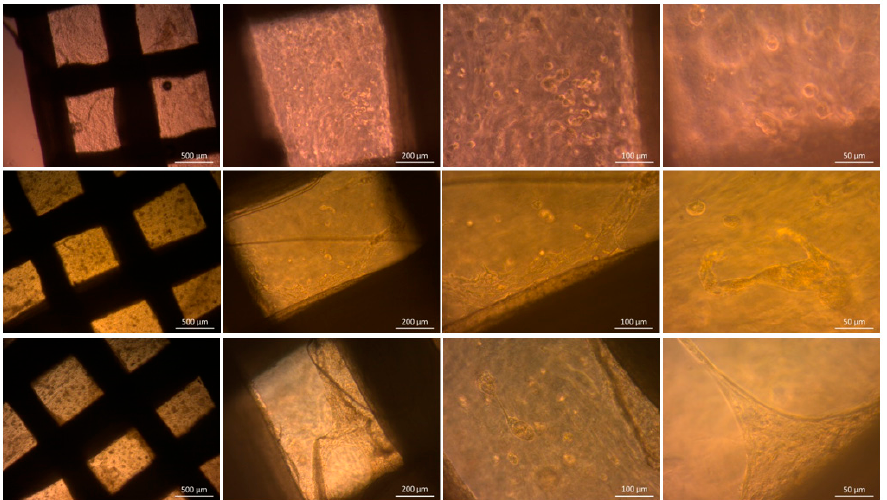
Figure 12. Optical microscope images of PCL-PEG ADA-GEL constructs with ST2 cells: after fabrication ( upper row ); after 14 days of incubation ( middle row ); and after 28 days of incubation ( bottom row ).